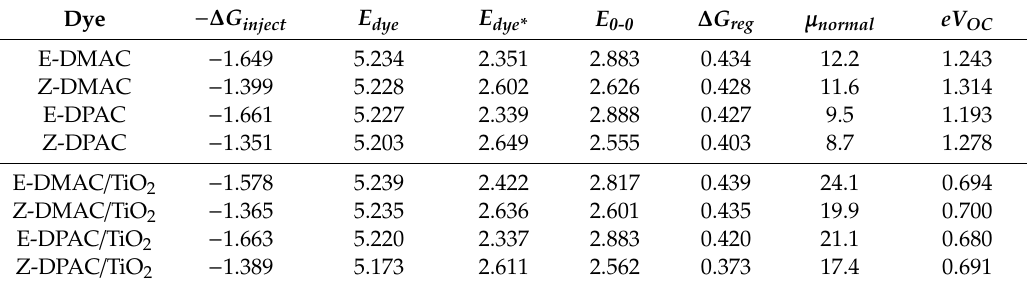
Table 5. Electron injection free energy ( ∆ G inject ), ground ( E dye ) and excited ( E dye* ) state oxidation potentials, vertical transition energy ( E 0 − 0 ), total regeneration energy ( ∆ G reg ), and dipole moment perpendicular to the surface of TiO 2 ( µ normal ) of DMAC and DPAC as isolated dyes and dye / TiO 2